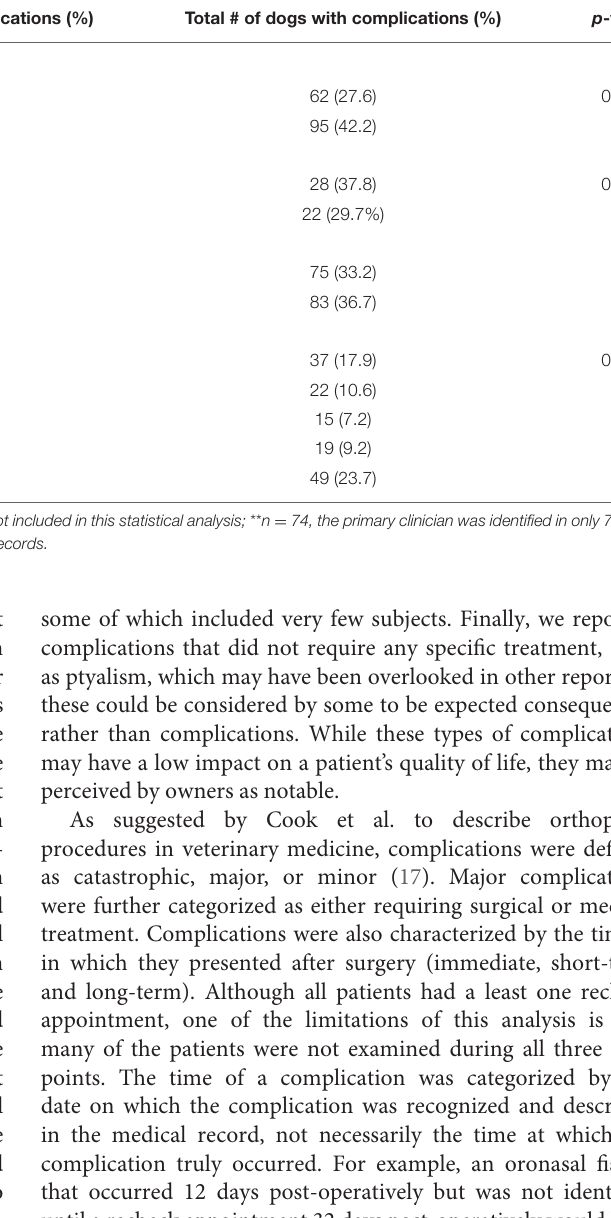
TABLE 4 | The number of dogs ( n = 226) which developed complications as categorized by the components of the defined surgical environment.